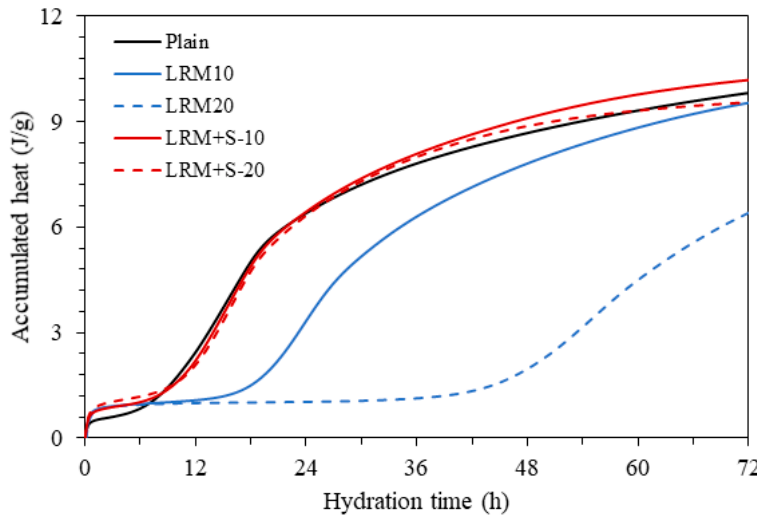
Figure 4. Accumulation of heat for the various cement paste samples.